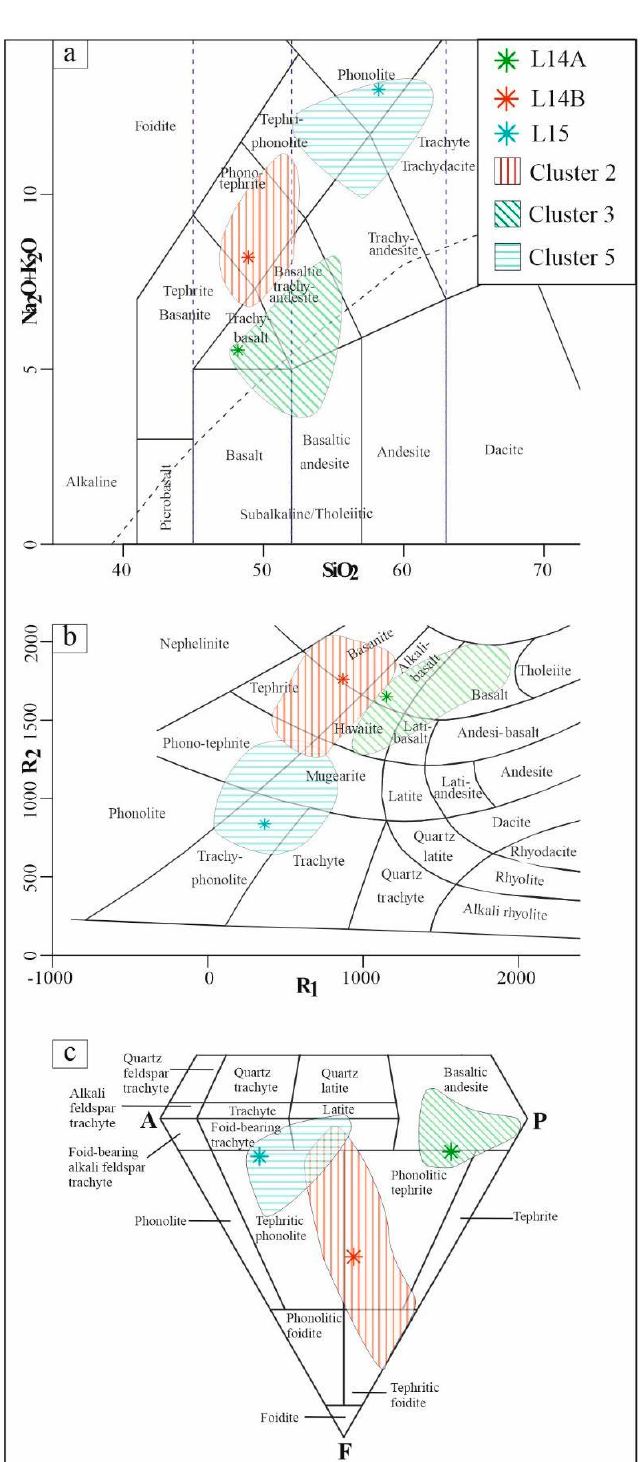
Figure 4. Conventional classification diagrams for major elements and modal composition of extrusive igneous rocks. ( a ) TAS; ( b ) R1-R2; ( c ) AQPF (modal classification of igneous rocks). The corners of the double triangle are A = alkali feldspar, P = plagioclase and F = feldspathoid. A marked difference in trace element geochemistry between sample L14A vs L14B and L15 is apparent. L14A fits well in the range of the Etna rocks. L14B and L15 have a negative Nb-Ta and Eu negative anomaly which is not apparent in the Etna rocks. L14B fits with the Roccamonfina leucite-bearing rocks, which have REE like the Etna rocks but